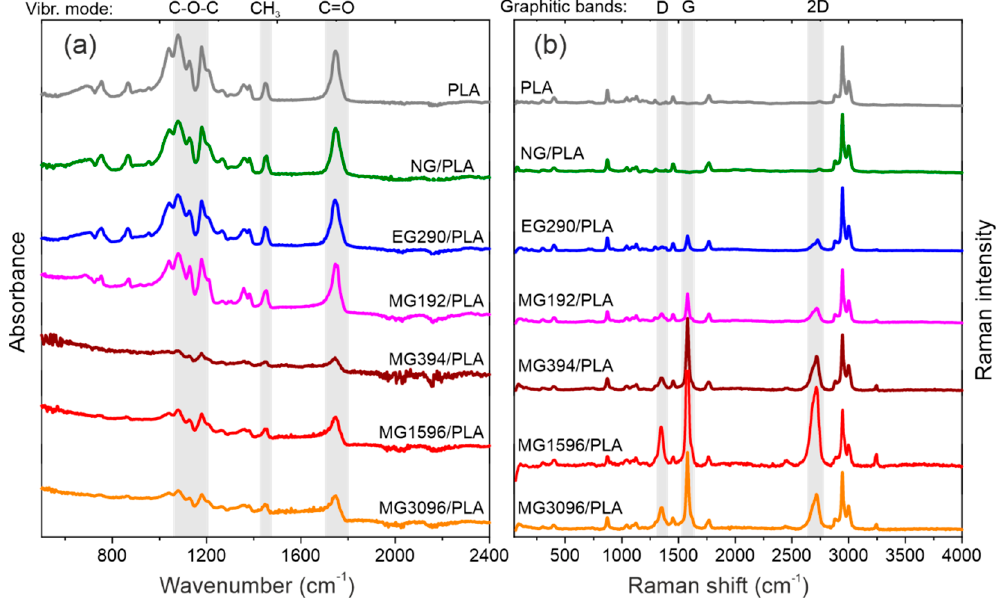
Figure 2. ATR − FTIR ( a ) and Raman scattering ( b ) spectra of graphite/PLA composites. Figure 2. ATR-FTIR ( a ) and Raman scattering ( b ) spectra of graphite/PLA